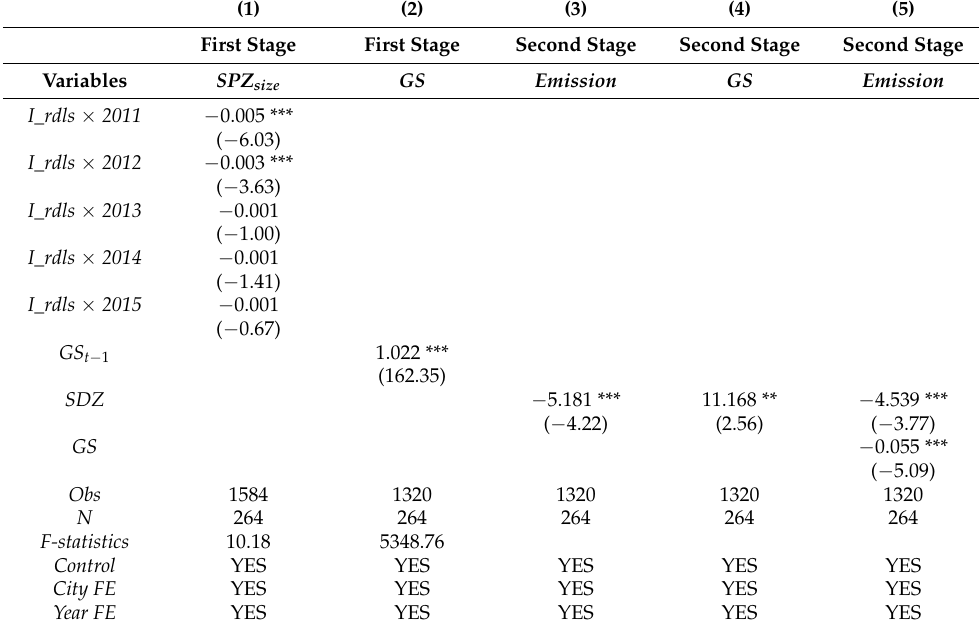
Table 6. Endogeneity test.